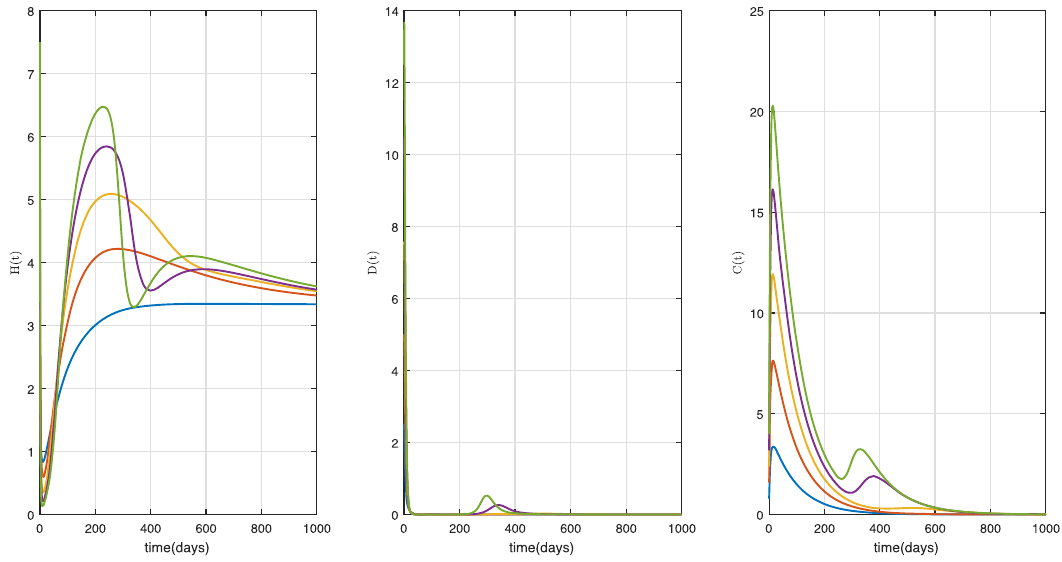
and (cid:3) = < 0.8906 1 2 . There is 0